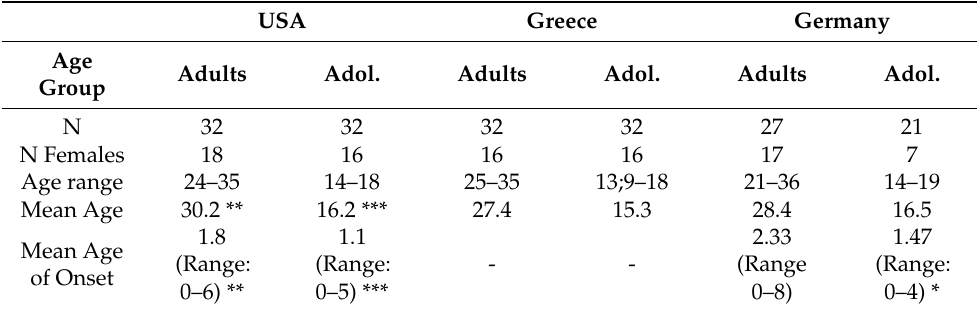
Table 1. Participant information.